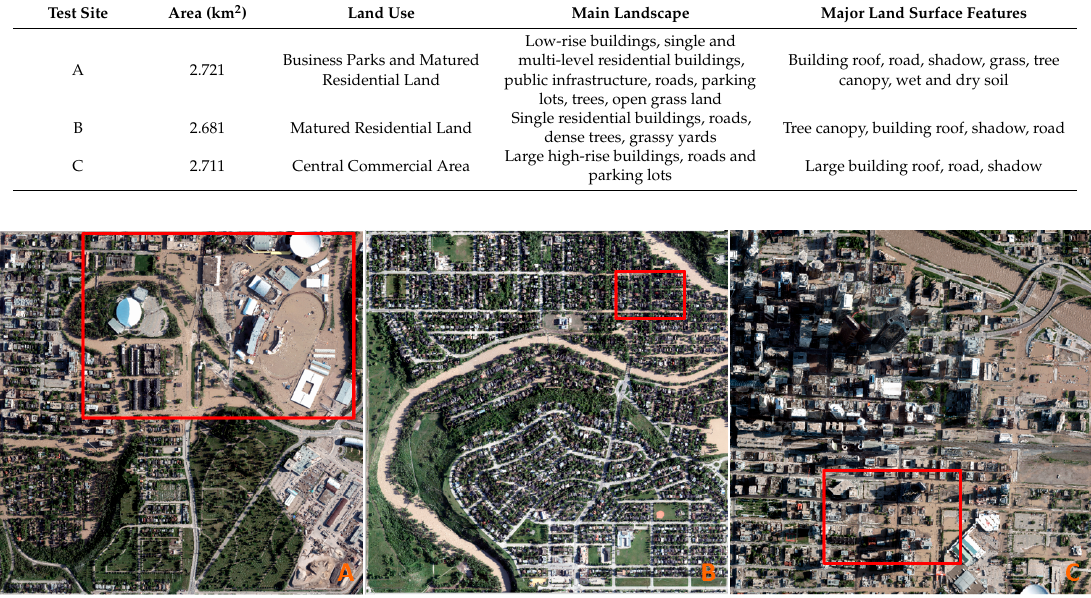
Figure 2. The aerial photos of three test sites. The red-colored frames within individual test sites are selected coverages of the flooded areas in Figure selected coverages of the flooded areas in Figure 8.